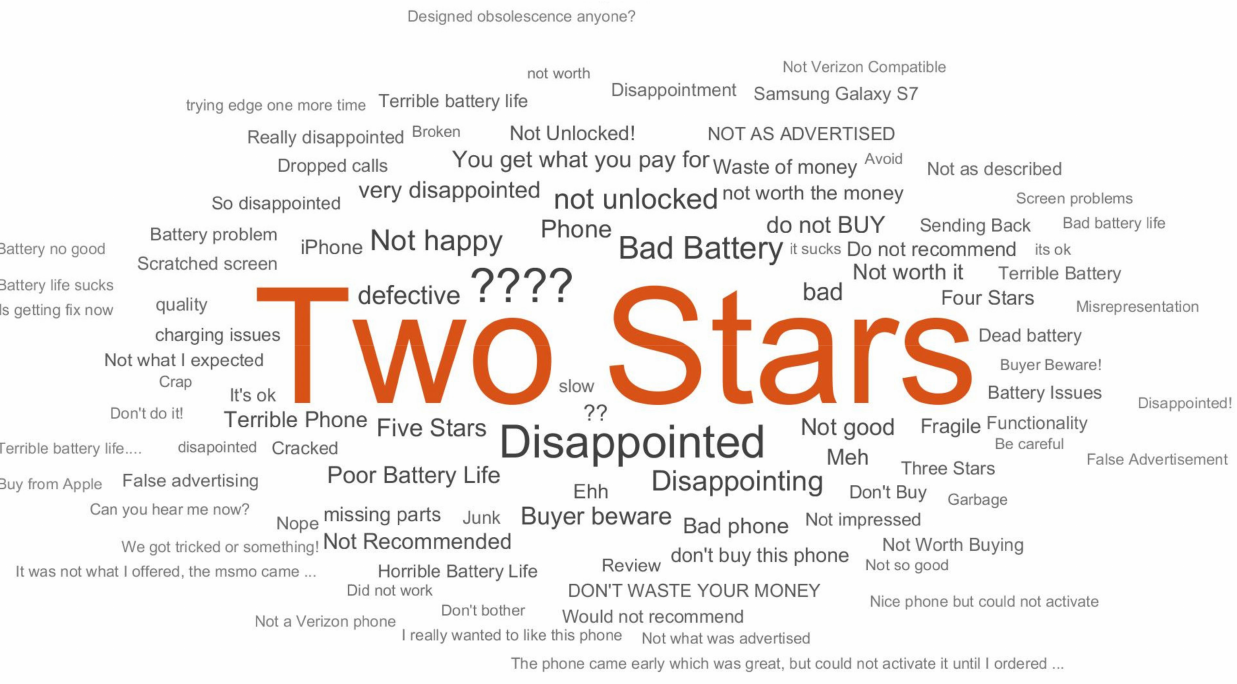
Figure 15. Word-cloud plot analysis for words with review score